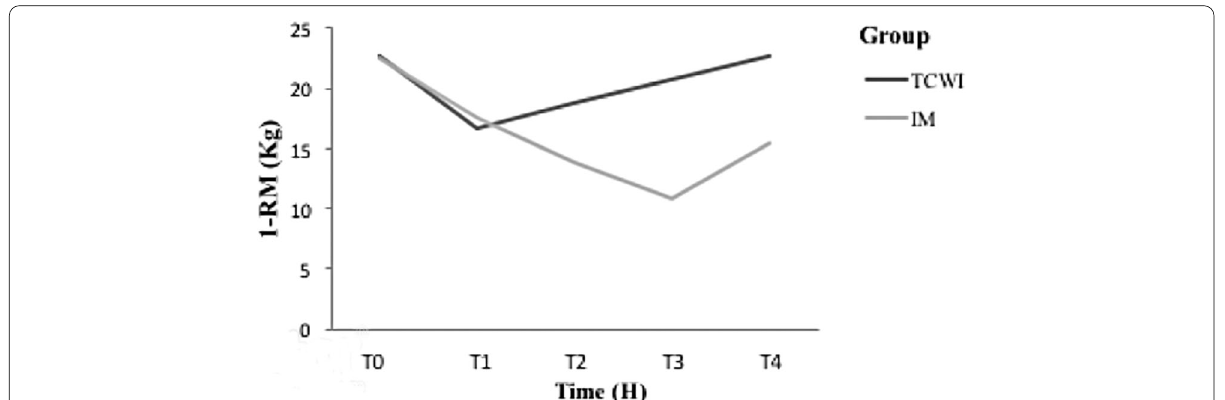
Fig. 2 Variation of one-repetition maximum’s values between groups at different